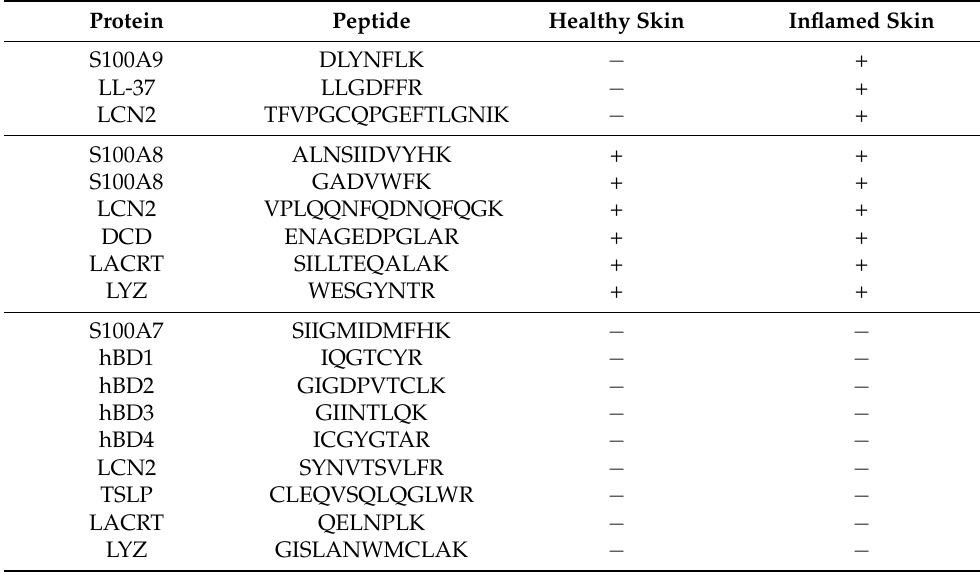
Table 2. List of the identified AMPs in the SC of healthy and inflamed skin samples. AMPs in healthy and inflamed skin were identified by PRM-based mass spectrometry analysis. The examined protein, the characteristic unique peptide along with their presence or absence in the examined sample is listed. ‘+’ sign indicates the presence, while ‘ − ’ sign indicates the absence of proteins. The proteins are labelled by their gene